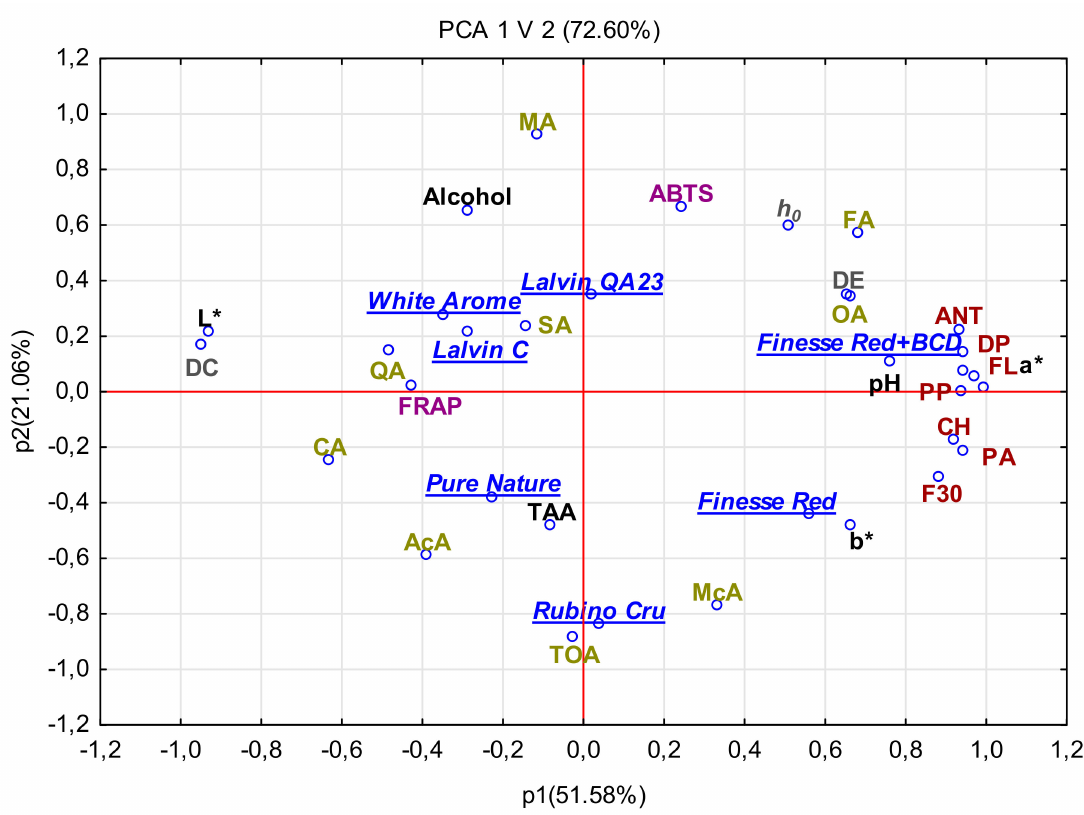
Figure 3. Principal component analysis (PCA) in red apple ciders after storage. ANT, anthocyanins; PA, phenolic acid; PP, polymeric procyanidin; CH, chalcones; F3O, flavonols (monomers and oligomers); DP, degree of polymerization; FL, flavonols; TOA, sum of organic acids; CA, citric acid; AcA, acetic acid; McA, maleonic acid; QA, quinic acid; OA, oxalic acid; SA, succinic acid; FA, fumaric acid; MA, malic